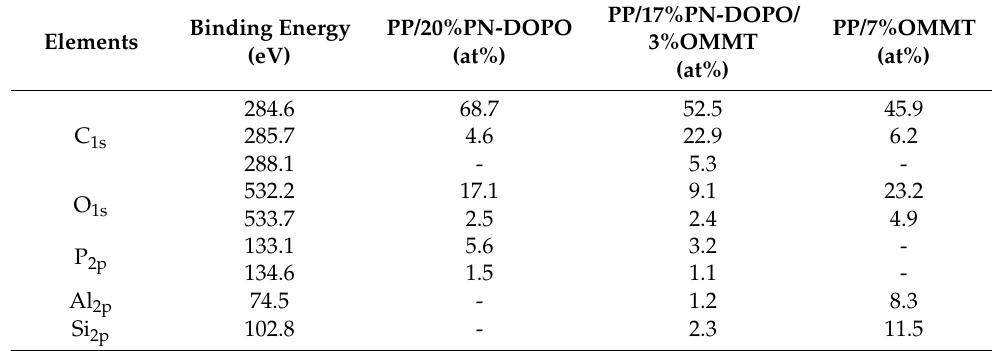
Table 5. XPS data of the char residues of flame-retarded PP composites.